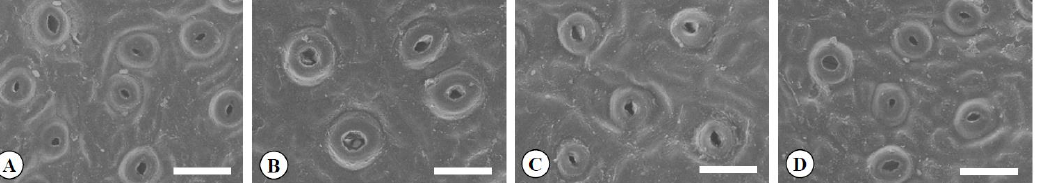
Figure 3. Transversal sections of leaves in the diploid ( A ), the tetraploid ( B ), the Yubeni ( C ), and the chimera ( D ) of the Meiwa kumquat. Bar = 100 μm. EP: Epidermis, PP: Palisade parenchyma, SP: Spongy parenchyma.